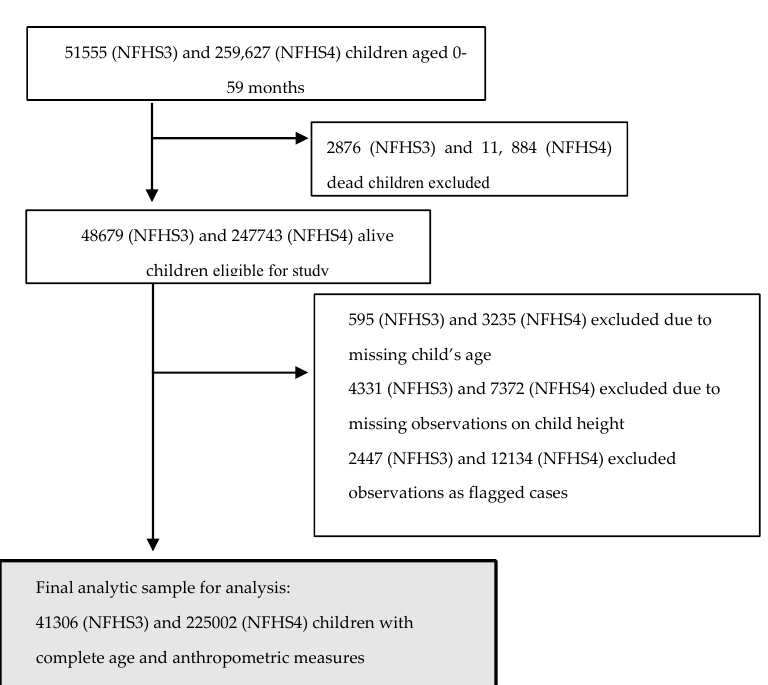
Figure A1. Flow diagram showing exclusions and final sample sizes of the study population, Indian National Family Health Survey 2005 – 2006 and 2015 – 2016.